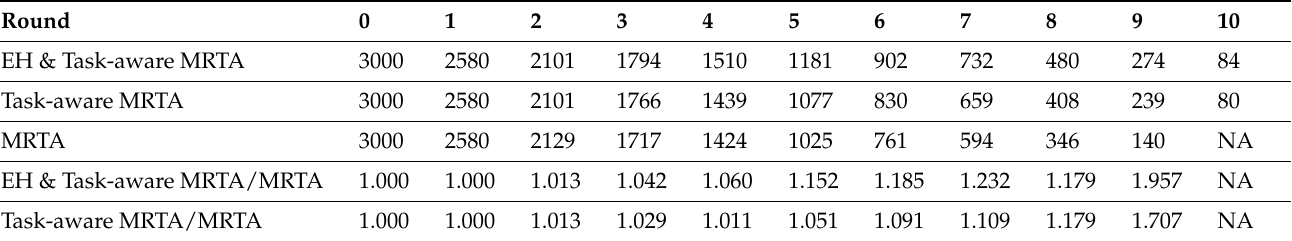
Table 4. Total remaining energy in the batteries of the five Markov EH robot nodes, which are located initially as given in Figure 6 versus the number of rounds under Markov EH processes. “NA” denotes not